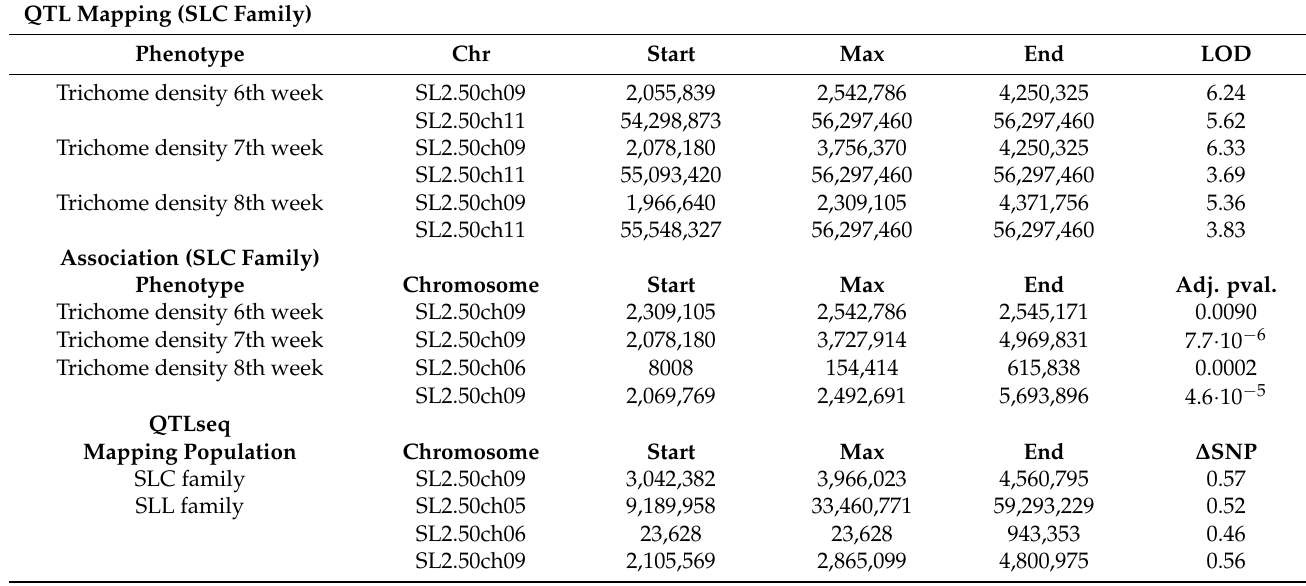
Table 2. QTL location based on different methods using SLC family and SLL family mapping populations. For each QTL, chromosome, start and end position, location of the most significant value of the region (Max) and LOD, adjusted p -value or ∆ SNP value for that location are reported.